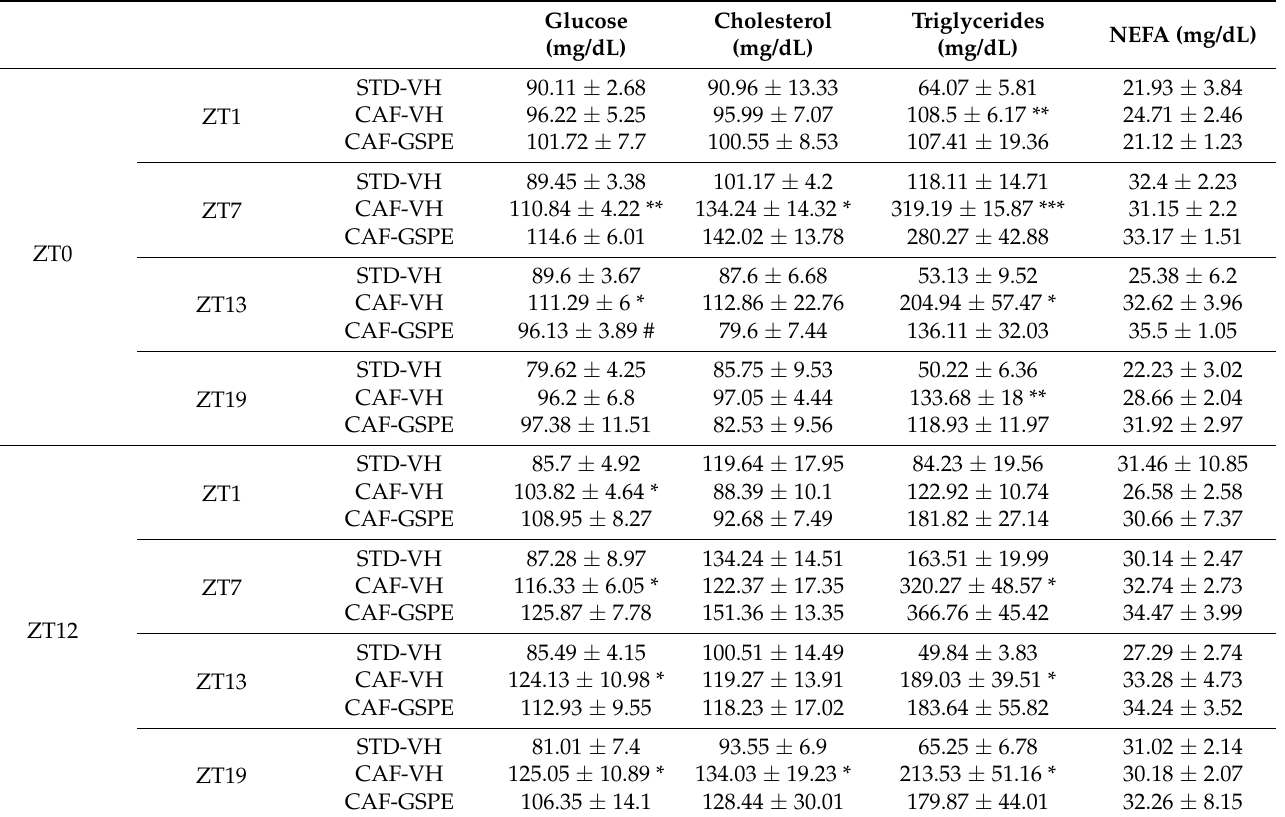
Table 2. Biochemical parameters of rats fed with STD or CAF diet supplemented with vehicle or